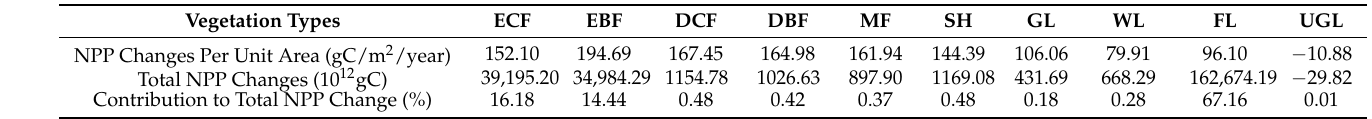
Table 4. Contribution of the different unchanged vegetation types to the total NPP changes in the six provinces along the southeast coast of China.